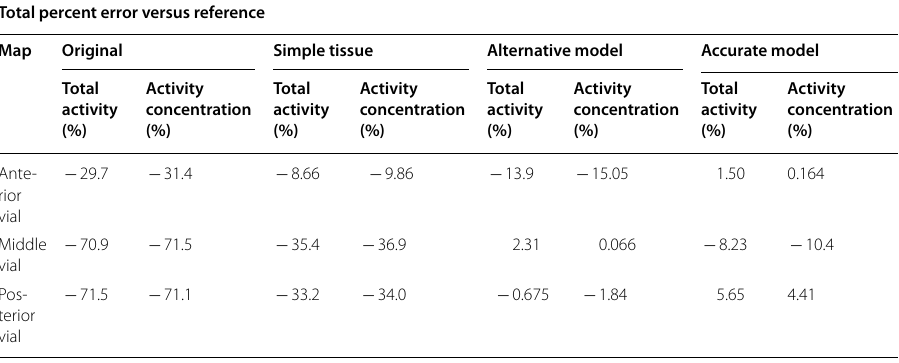
Table 5 Percent errors of the individual total vial activities and activity concentrations compared to the reference vial Total percent error versus reference Map